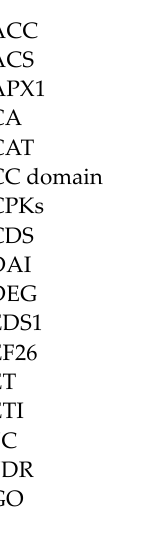
(b) predicted proteins showing 11 aminoacids substitutions; Figure S3: qRT‑PCR analysis of basal ex‑ pression of AsTIR19 and AdEXLB transgenes in the five independent tobacco OE lines and wild‑type; Figure S4: detached leaves of tobacco OE lines and WT stained by cotton blue and collected at 10 and 14 h after inoculation (HAI) with S. sclerotiorum ; Figure S5: hypothetical representation of immune re‑ sponses and signaling in EXLB:TIR19‑OE lines.; Table S1: Arachis stenosperma libraries (RNA‑Seq